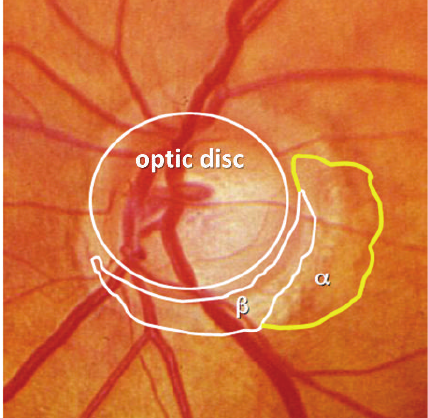
Figure 1: Color fundus image. The Zone alpha and beta peripapillary atrophy is near the